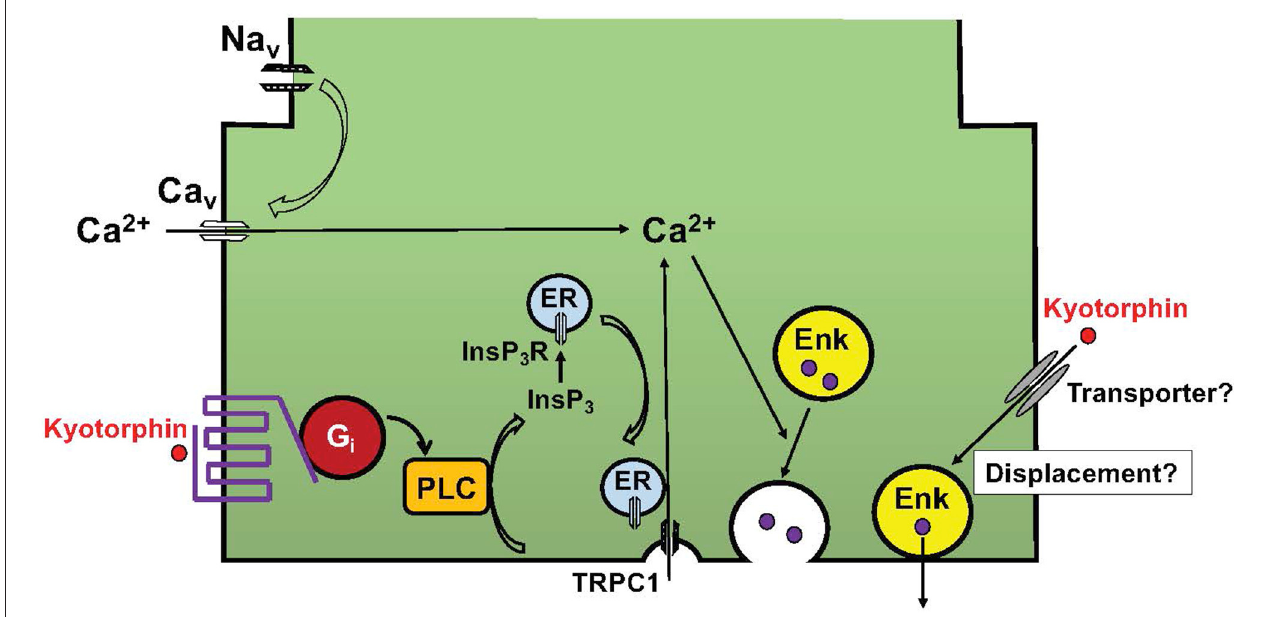
FIGURE 3 | Working hypotheses for the mechanisms underlying kyotorphin-induced Met-enkephalin release. The kyotorphin (Tyr-Arg) receptor mediates the activation of G i and PLC. This signaling leads to the production of InsP 3 and activation of InsP 3 R in the endoplasmic reticulum (ER). The conformational coupling of InsP 3 R with TRPC1 opens plasma membrane Ca 2 + channels (24). This receptor-operated mechanism may enhance the recruitment of Met-enkephalin-containing synaptic vesicles to the plasma membranes. Although no evidence is available, but it is interesting to speculate that kyotorphin is incorporated into nerve terminals, and thereby displaces and excretes Met-enkephalin from synaptic vesicles attached to the plasma